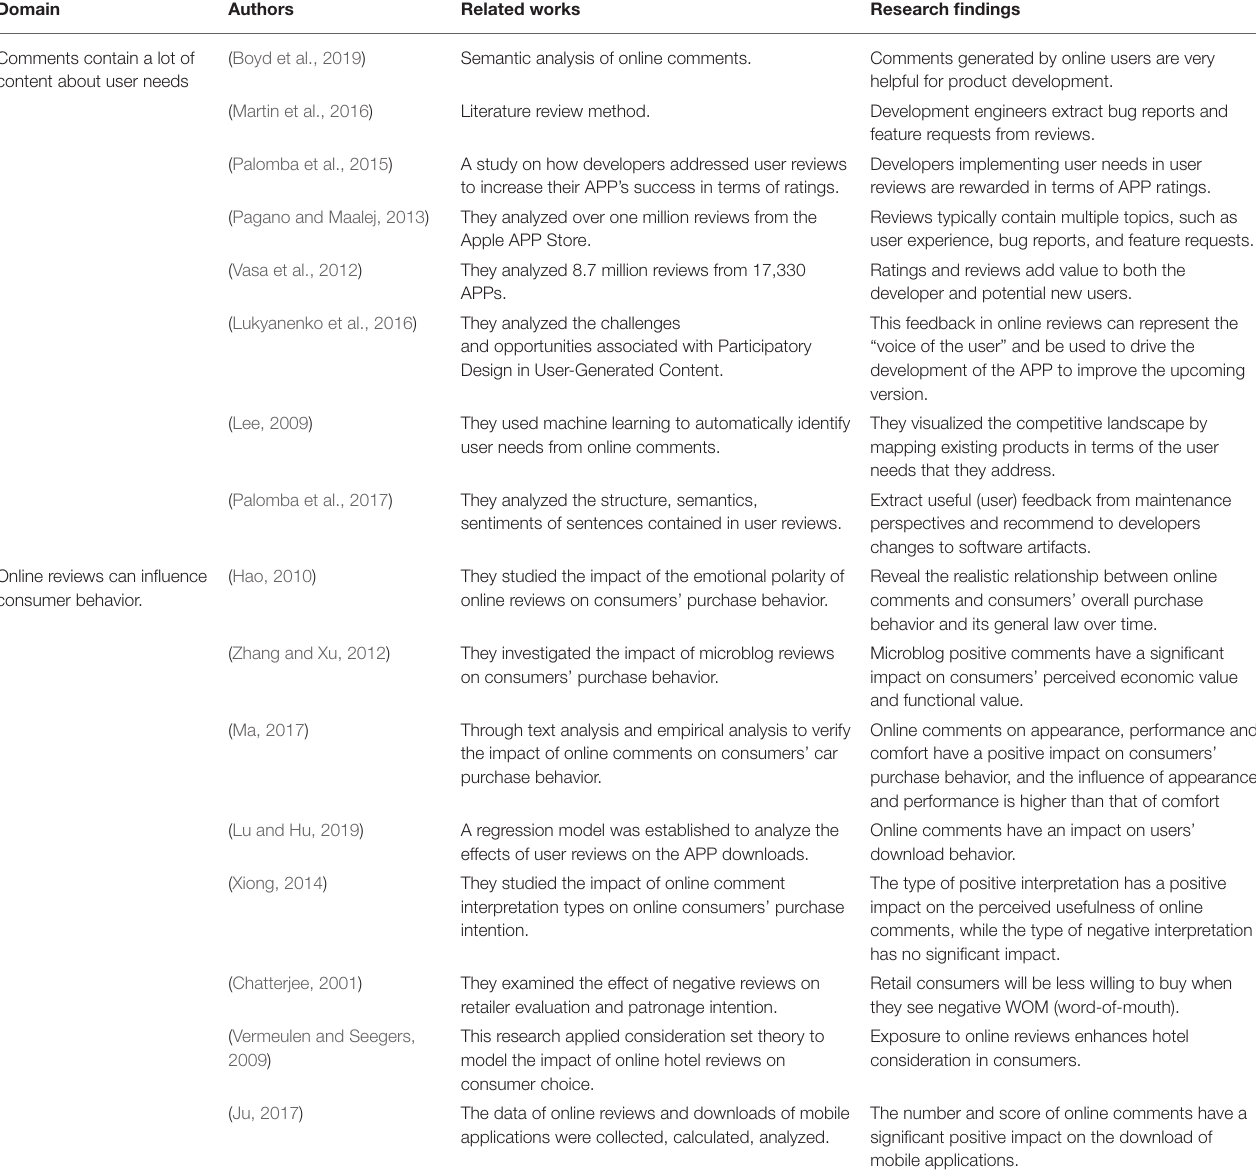
TABLE 1 | Prior works and